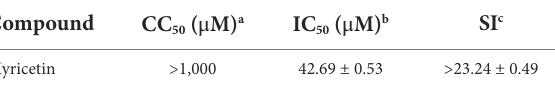
TABLE 2 Antiviral activity of myricetin against